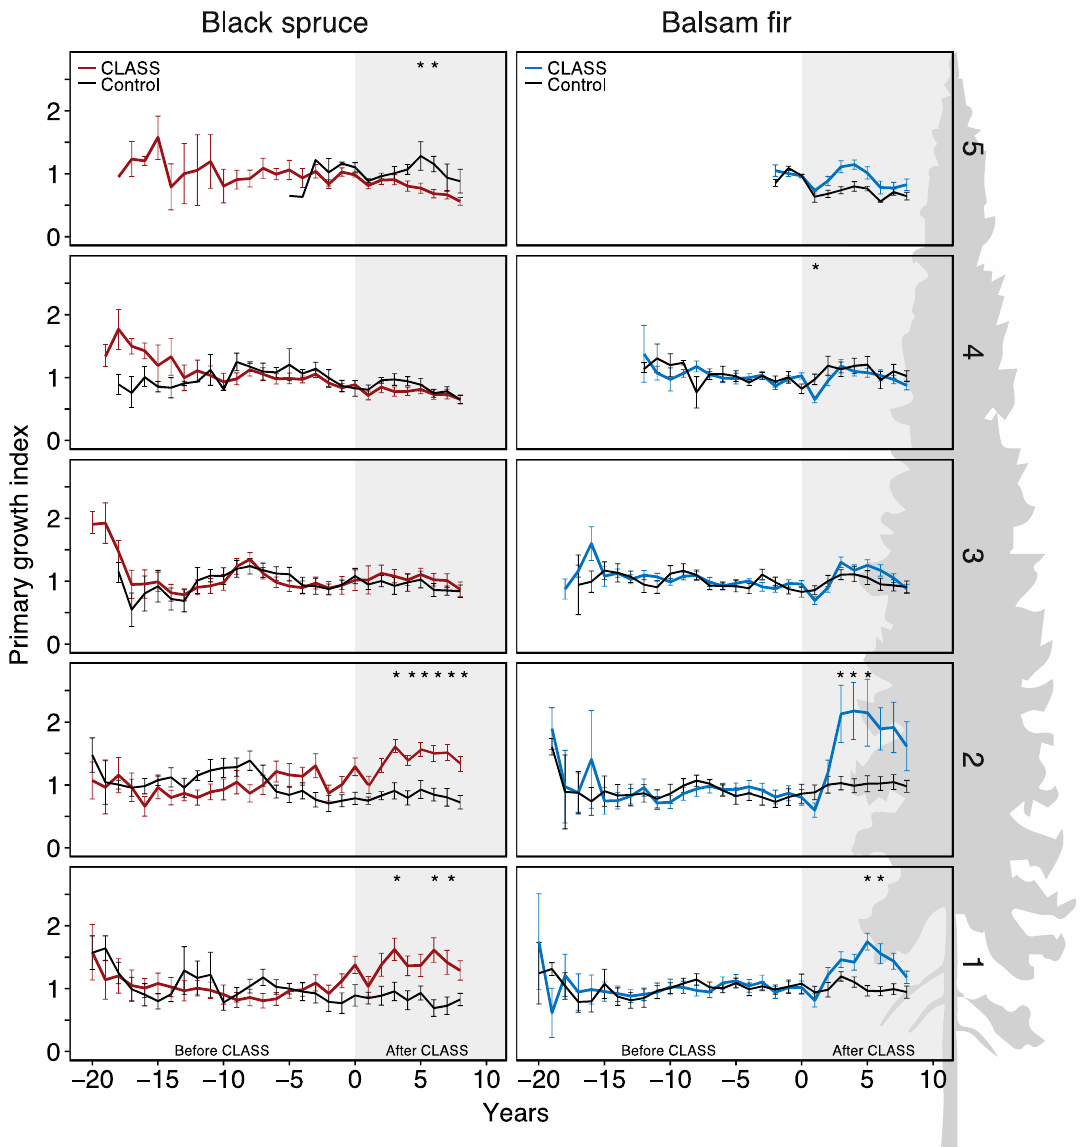
Figure 3. Mean branch primary growth index ( ± se) in the five sections of the live crown for black spruce and balsam fir before and after CLASS. The grey area represents the years post-treatment, with Year 0 being the treatment year. Stars indicate a significant difference between the treated and control trees for a given year, obtained from the contrasts. The missing data for the years before treatment for branches from the highest two sections indicates that these are newly formed branches.